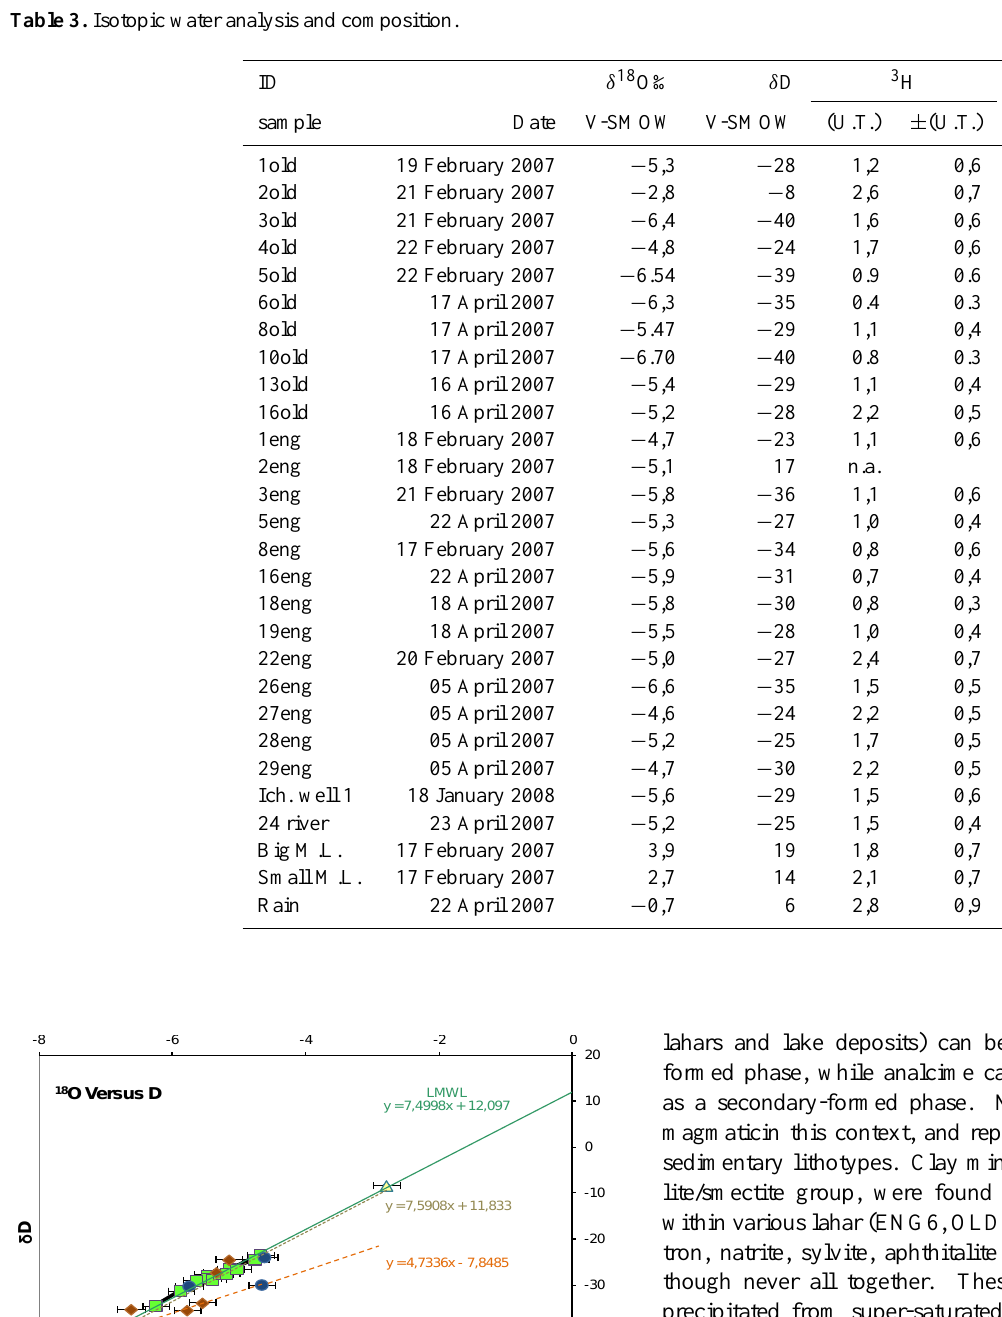
Table 3. Isotopic water analysis and composition.